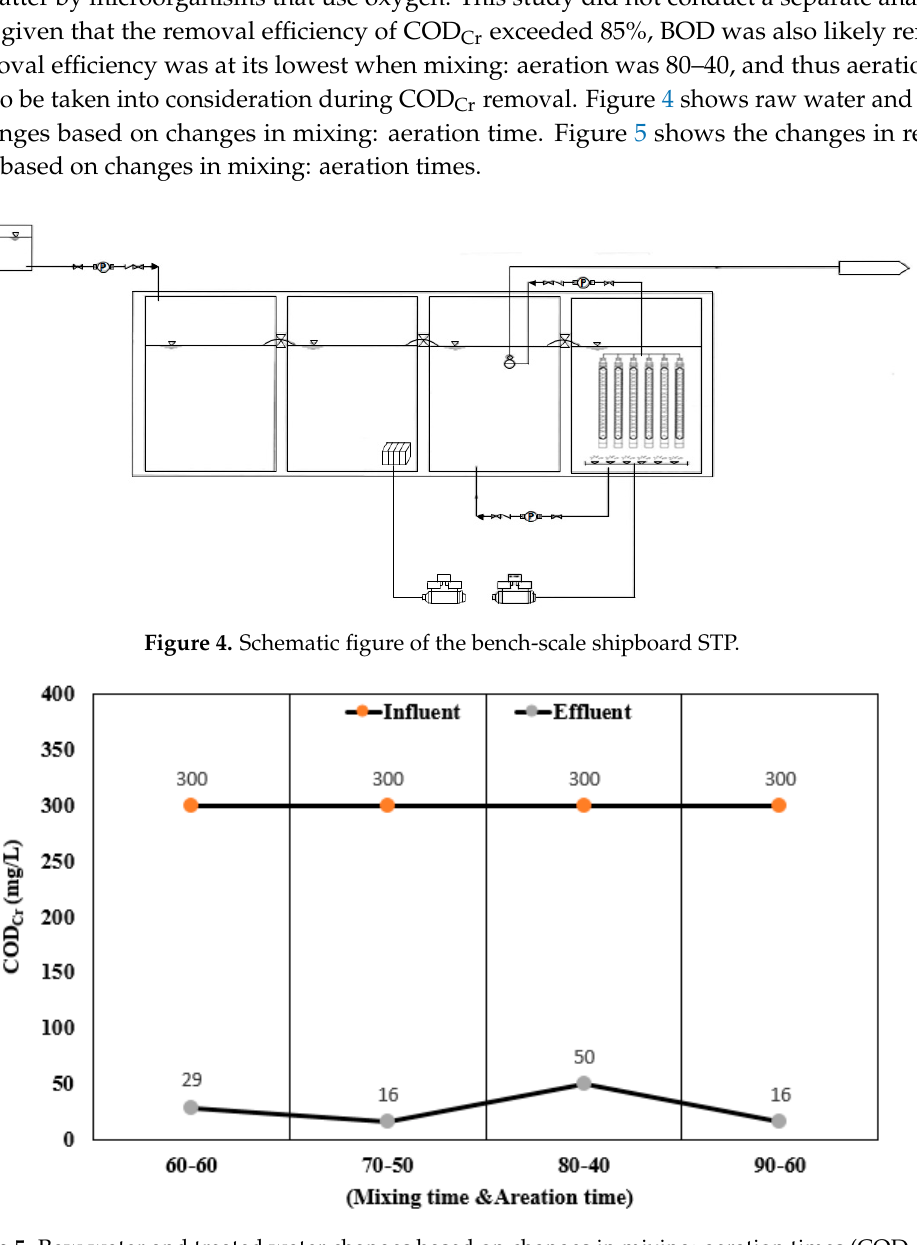
Figure 5. Raw water and treated water changes based on changes in mixing: aeration times (COD Cr ).